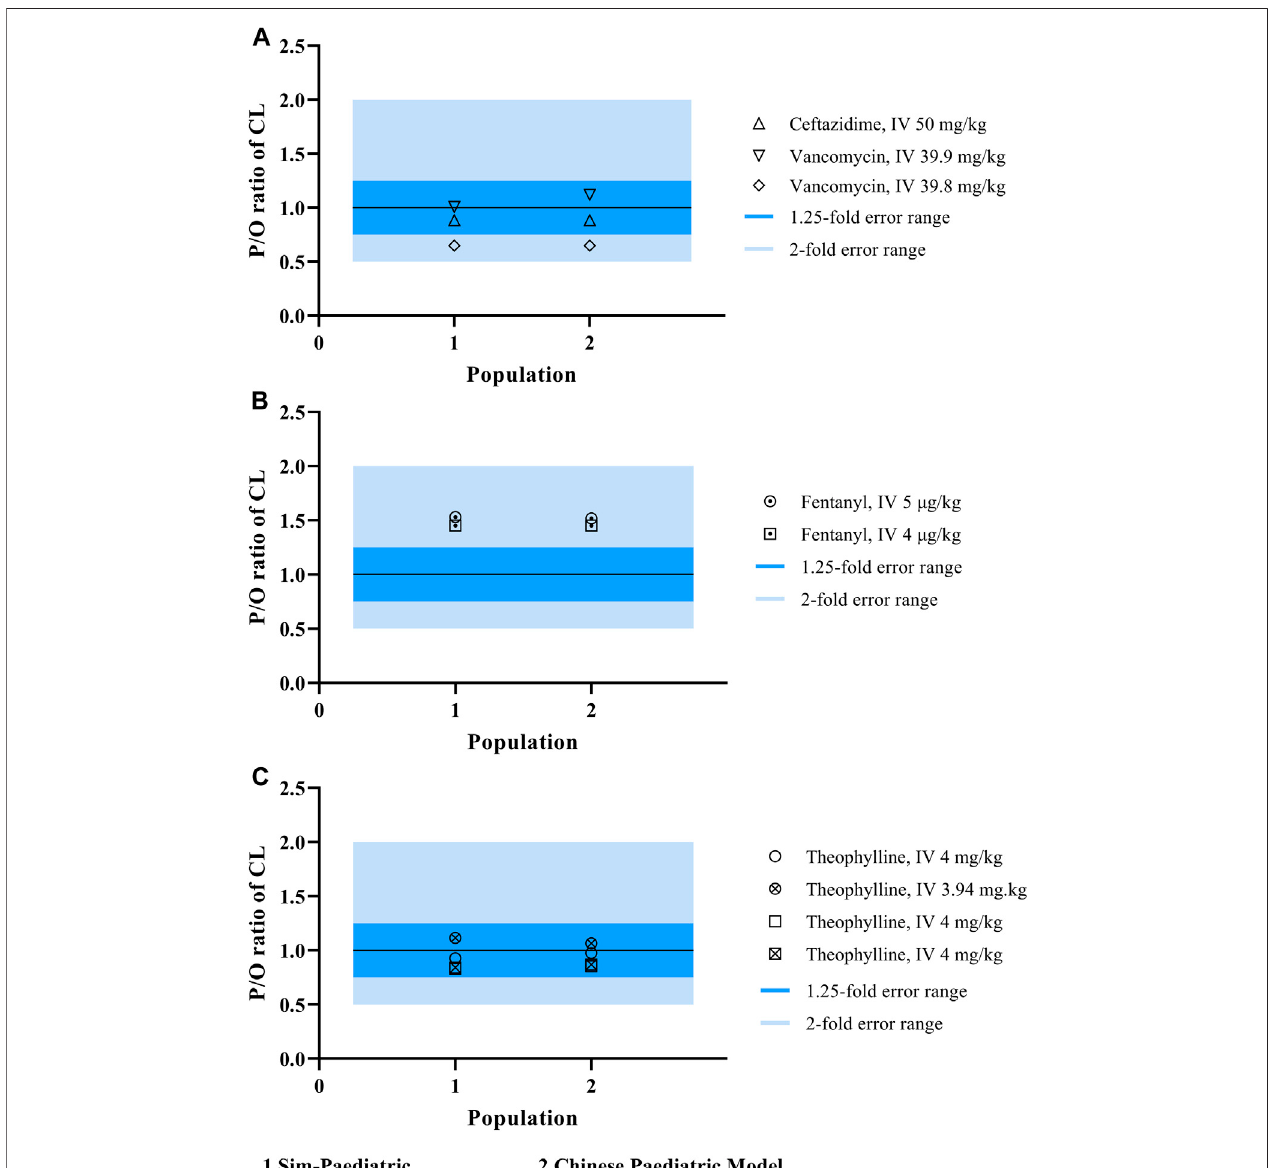
FIGURE 5 | The P/O ratio of CL simulated by both NEC pediatric population model and Chinese pediatric population